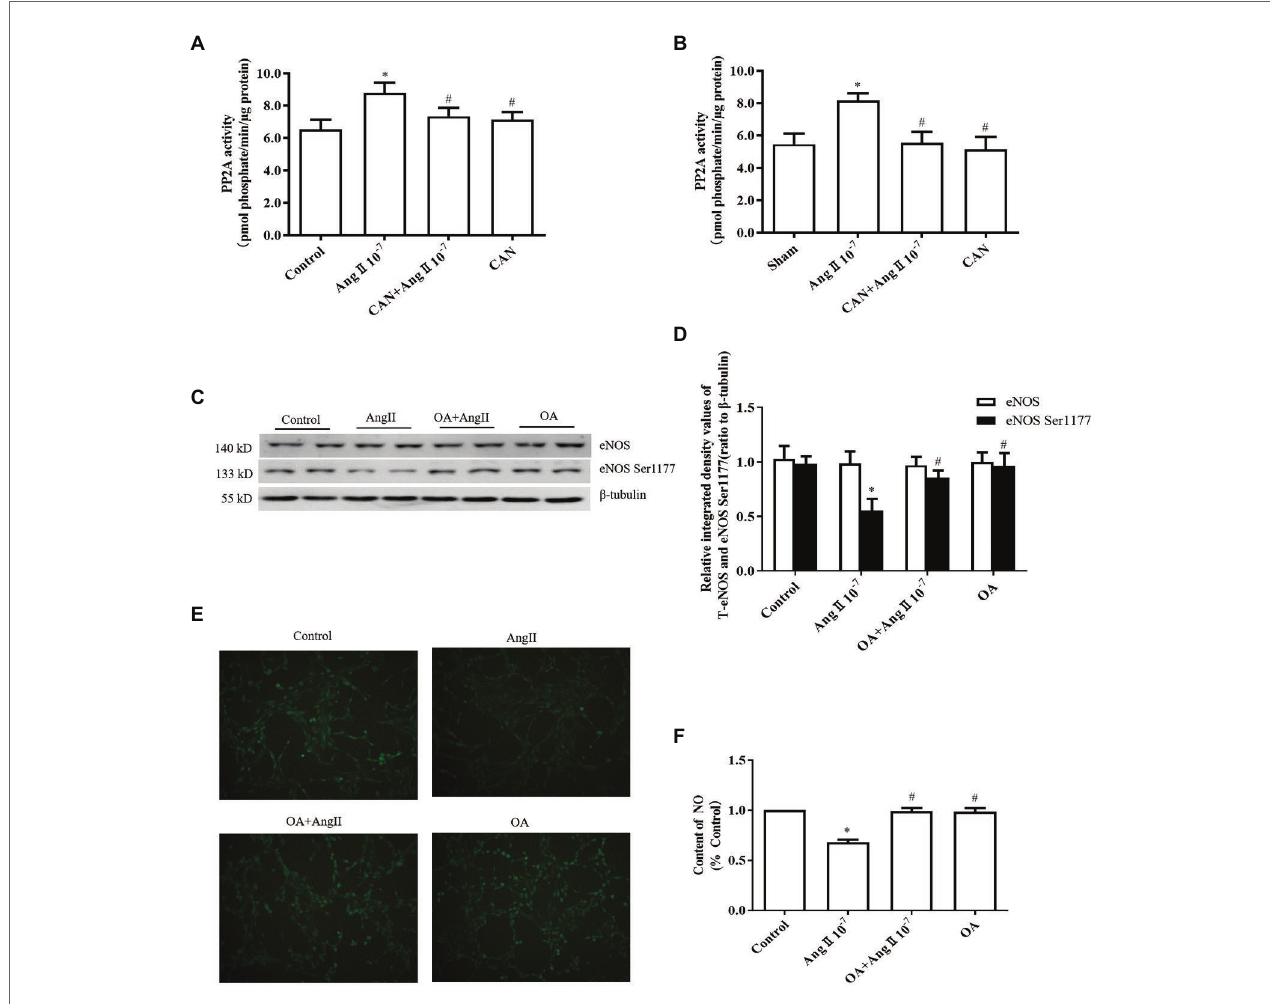
FIGURE 2 | The AngII/AT 1 R pathway reduces the levels of eNOS Ser1177 phosphorylation and NO production by activating protein phosphatase 2A (PP2A). (A) AngII augmented PP2A activity, while CAN blocked AngII-mediated enhancement of PP2A activity. HUVECs were pretreated with 10 −6 M CAN for 3 h or not, then stimulated with 10 −7 M AngII for 12 h ( n = 4 independent experiments). (B) PP2A activity was increased in the mesenteric arteries of AngII-infused rats. CAN blocked AngII-induced upregulation of PP2A activity ( n = 3 rats per group). (C,D) PP2A inhibitor (OA) blocked the effect of AngII on eNOS Ser1177 in vitro . HUVECs were pretreated with 10 −8 M OA for 1 h or not, then stimulated with 10 −7 M AngII for 12 h ( n = 6 independent experiments). (E,F) OA blocked AngII-induced downregulation of NO production in HUVECs (200× magnification; n = 4 independent experiments). * p < 0.05 vs. Control or Sham group; # p < 0.05 vs. AngII